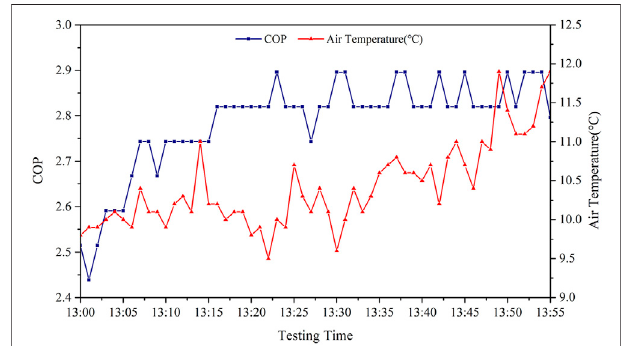
FIGURE 11 | The COP and outdoor air temperature in condition 6.